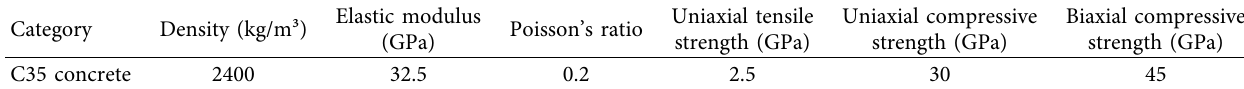
Table 1: C35 concrete mechanical property parameters.